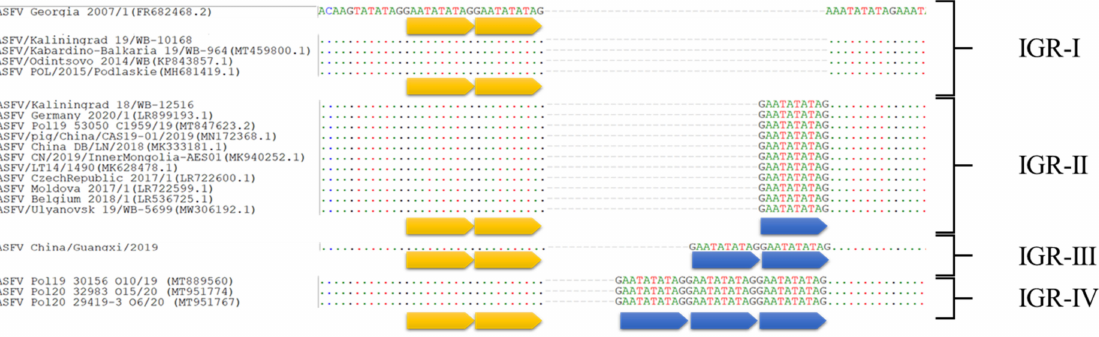
Figure 4. Nucleotide alignment of ASFV samples based on the sequences of the intergenic region (IGR) between I73R and I329L . Each arrow denotes one TRS; yellow arrows indicate TRSs identical in quantity to the reference isolate Georgia 2007/1; blue arrows represent additional